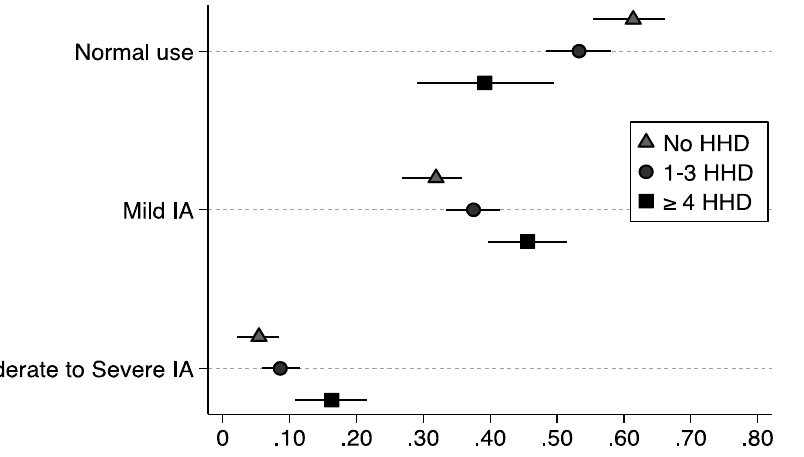
Figure 1. Predicted probability with 95% confidence intervals of normal Internet use, mild Internet addiction, and moderate to severe Internet addiction for ACE groups, after adjusting for all covariates (i.e., age, gender, ethnicity, SES, COVID-19 employment loss, depression). There was a similar pattern of results in models assessing the association between HHD and PSU. Students who reported 1–3 household stressors had higher odds of PSU (AOR: 1.40, 95% CI: 1.02–1.93) than their peers who did not report HHD, and students who had ≥ 4 household stressors had approximately twice the odds (AOR: 2.03, 95% CI: